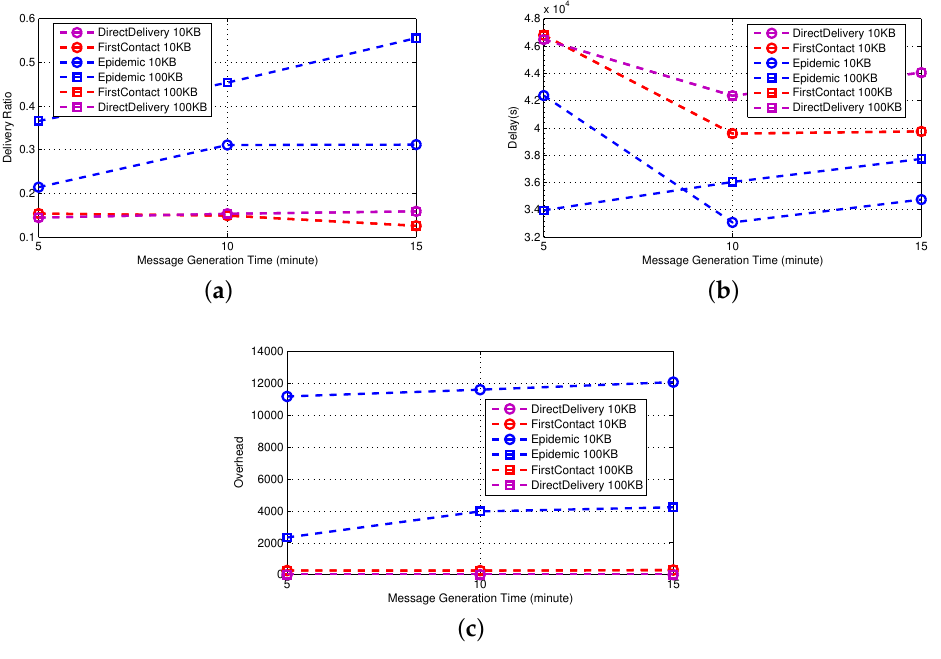
Figure 8. Performance of simple protocols in a real-world outdoor setting.